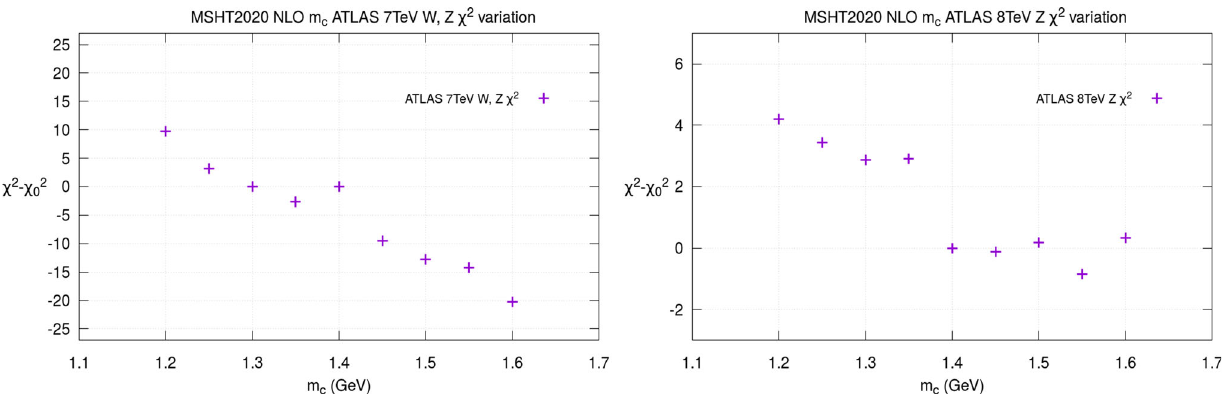
) = 0 . 118 for (left) the ATLAS 7 TeV W , Z data and (right) the Z